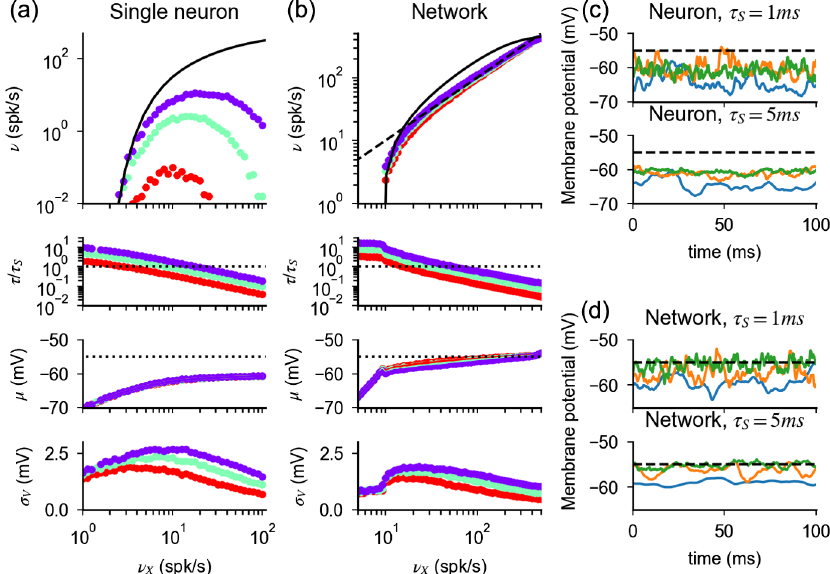
FIG. 6. Effects of synaptic time constant on single-neuron and network response. (a) Single-neuron response as a function of input rate ν , computed numerically from Eqs. (1) and (23). Different colors correspond to different values of τ (purple, 1 ms; blue, 2 ms; red, X S = τ ; significant deviations and 5 ms). Firing rates (first row) match predictions obtained for instantaneous synapses (lines) for small τ S = τ . The effective membrane time constant ( τ , second row) decreases with the input rate and response suppression emerge for larger τ S = τ ∼ 1 (dashed line) for lower levels of external drive when τ reaches the value τ is larger. The equilibrium value of the membrane S S potential ( μ , third row) increases with the input rate and is independent of τ (black dotted line represents the spiking threshold). The S magnitude of fluctuations of the membrane potential ( σ , fourth row) has a nonmonotonic relationship with the input rate and peaks at a V value of ν for which τ is of the same order as τ . (b) Analogous to (a) but in the network case. Firing rates are no longer suppressed as X S τ = τ increases but approach the response scaling predicted by Eq. (21) (dashed line). As discussed in the text, high firing rates are S obtained by increasing the value of μ toward threshold. (c) Examples of membrane potential dynamics for a single neuron in the absence 5 (blue), 40 (orange), and 100 spk/s of spiking mechanisms and for two different values of τ . Colors correspond to increasing ν S X ¼ (green), respectively. High-frequency fluctuations are suppressed as ν increases. (d) Analogous to (c) but in the network case and for X ν 5 , 40, and 100 spk/s. Increasing ν reduces recurrent inhibition and produces membrane potential trajectories which are X ¼ X increasingly closer to the firing threshold. Simulations parameters are K ¼ 10 3 , a ¼ 0 . 01 , g ¼ 12 , η ¼ 1 . 4 , and γ ¼ 1 = 4 (single neuron); K ¼ 10 3 , a ¼ 0 . 002 , g ¼ 22 , and γ ¼ 1 = 4 (network). Simulations are performed with the simulator BRIAN 2 [71], with neurons receiving inputs from independent Poisson units firing at rates K ν and γ K ην , in the single-neuron case, or K ν , in the network case. X X X 10 K excitatory and inhibitory Network simulations use N E;I ¼